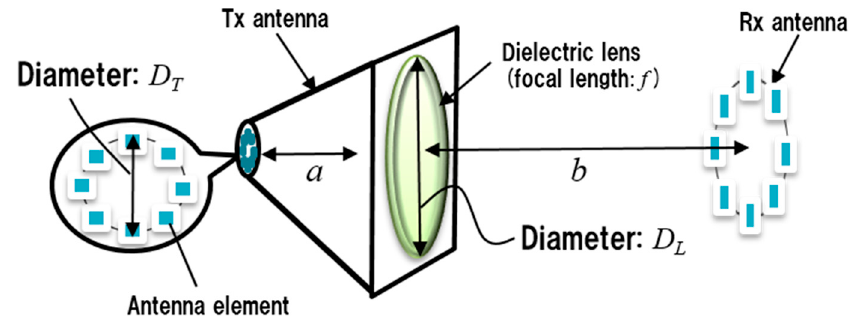
Figure 3. Configuration of the Tx and Rx antennas using dielectric lens.